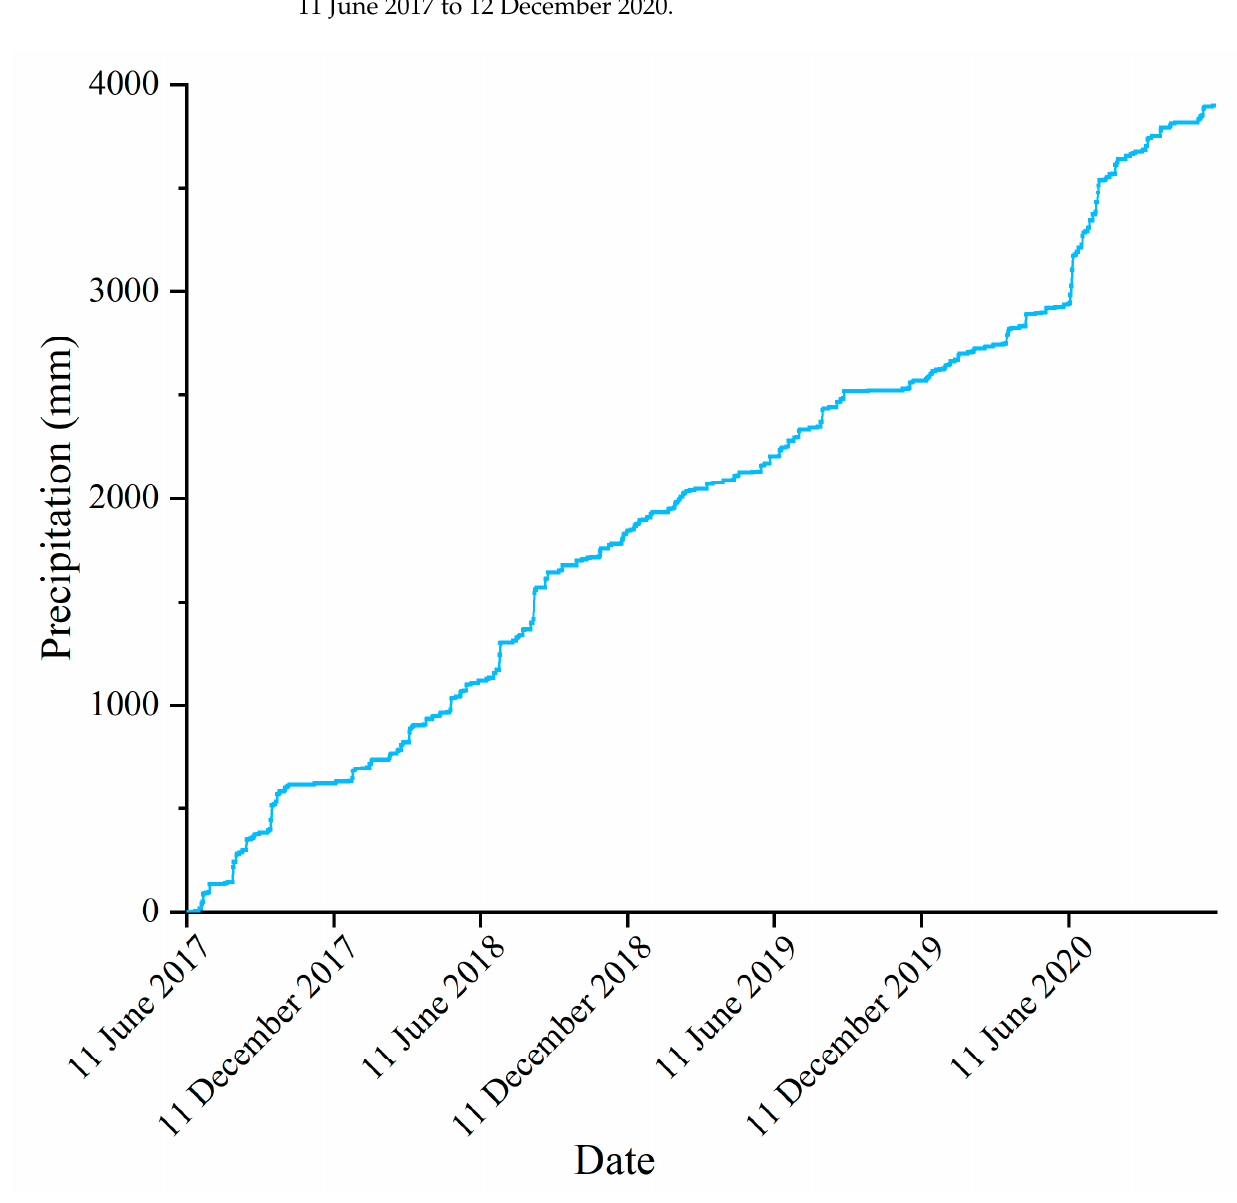
Figure 2. Cumulative rainfall in Nanjing from 11 June 2017 to 12 December 2020.